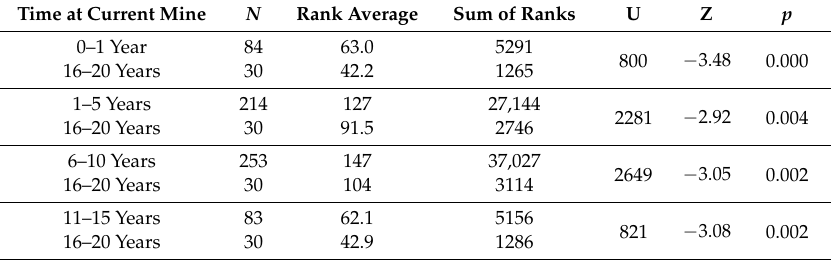
Table A5. Mann-Whitney results for mining experience and confidence in one’s ability to correctly explain or demonstrate “where to report in the event of a mine emergency”.